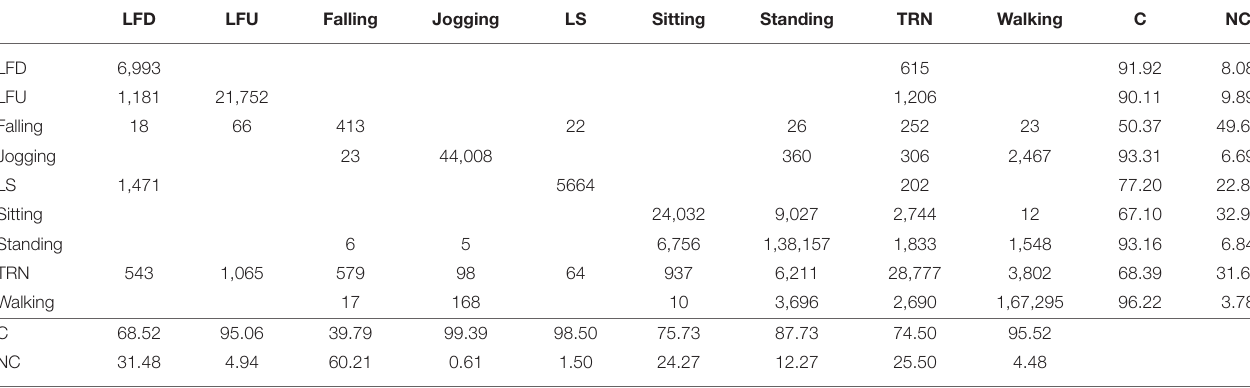
TABLE 5 | Confusion matrix using Bagging and Decision Tree using only the waist accelerometer.